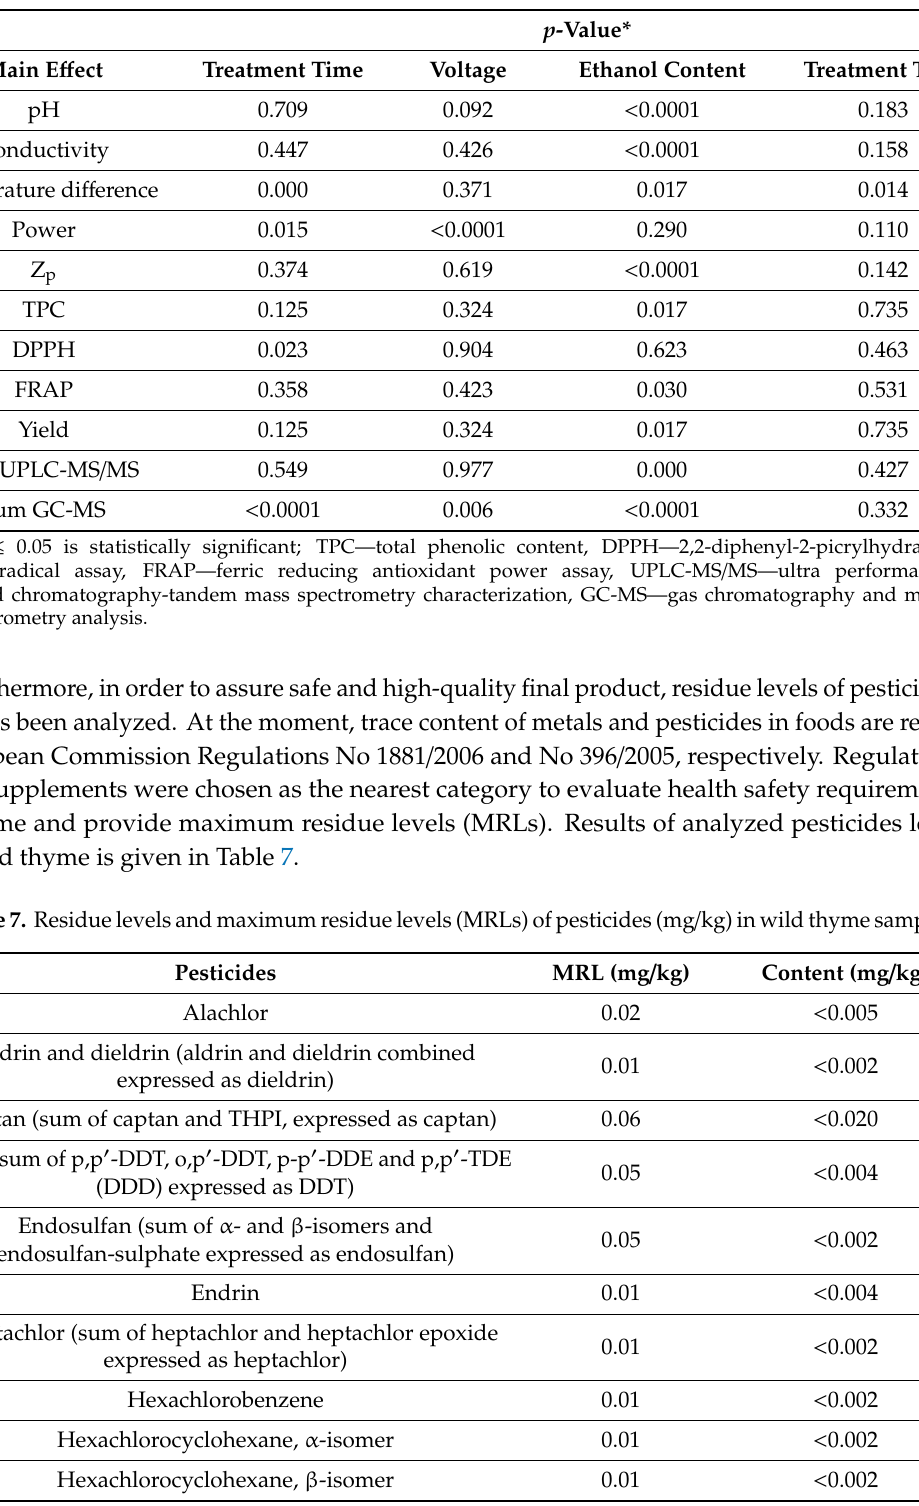
Table 6. Analysis of covariance (ANCOVA) for pH, conductivity, temperature di ff erence, power, TPC, FRAP, DPPH, yield of extraction and sum of all compounds measured by UPLC-MS / MS and GC-MS methods. The p -values present the statistical significance of each of the factors.